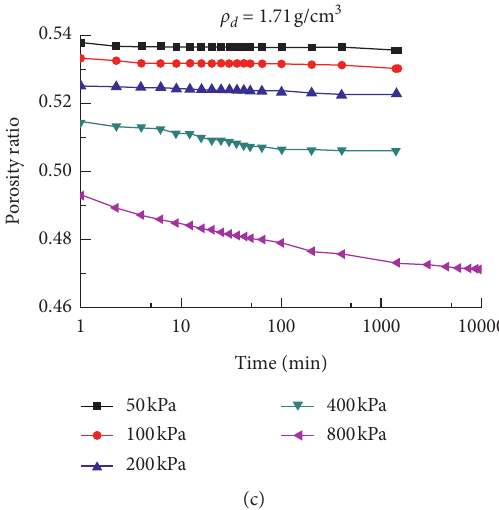
Figure 8: Consolidation test curve of expansive soil under various dry density